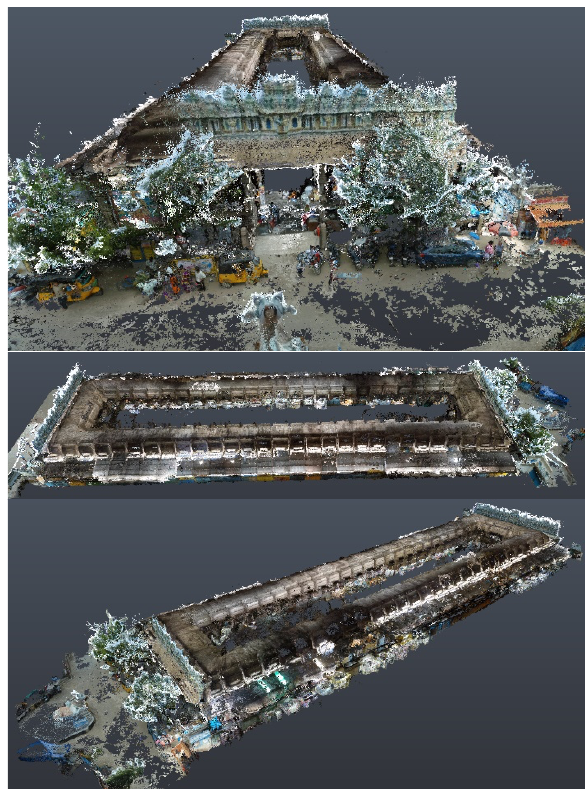
Figure 19 . The cleaned point cloud in Autodesk